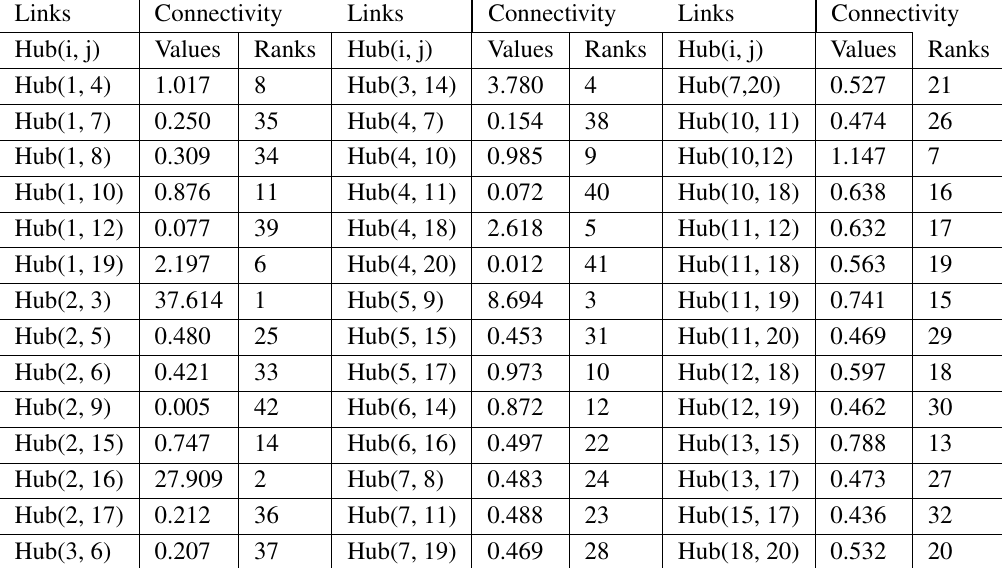
Table 5. Connectivity values (CV) and ranks of